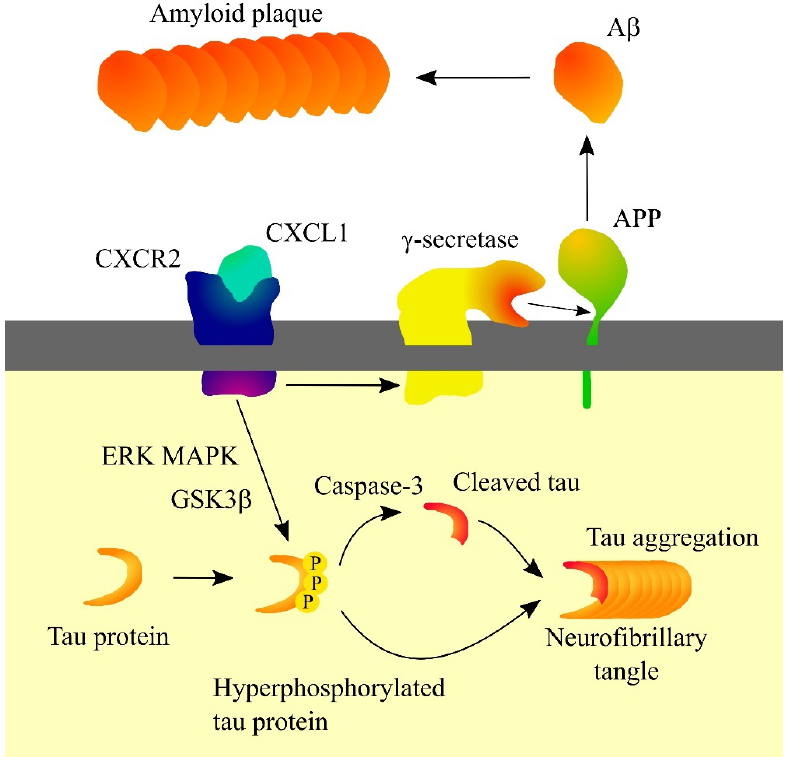
Figure 3. Significance of CXC motif chemokine ligand 1 (CXCL1) in Alzheimer’s disease. CXCL1, through its receptor CXC motif chemokine receptor 2 (CXCR2), causes hyperphosphorylation of tau protein which leads to a proteolytic cleavage of tau protein, which enables the formation of a neurofibrillary tangle. CXCR2 also increases γ -secretase activity. This results in increased release of amyloid β (A β ) and increased amyloid plaque formation. Abbreviations: A β —amyloid β ; APP—amyloid